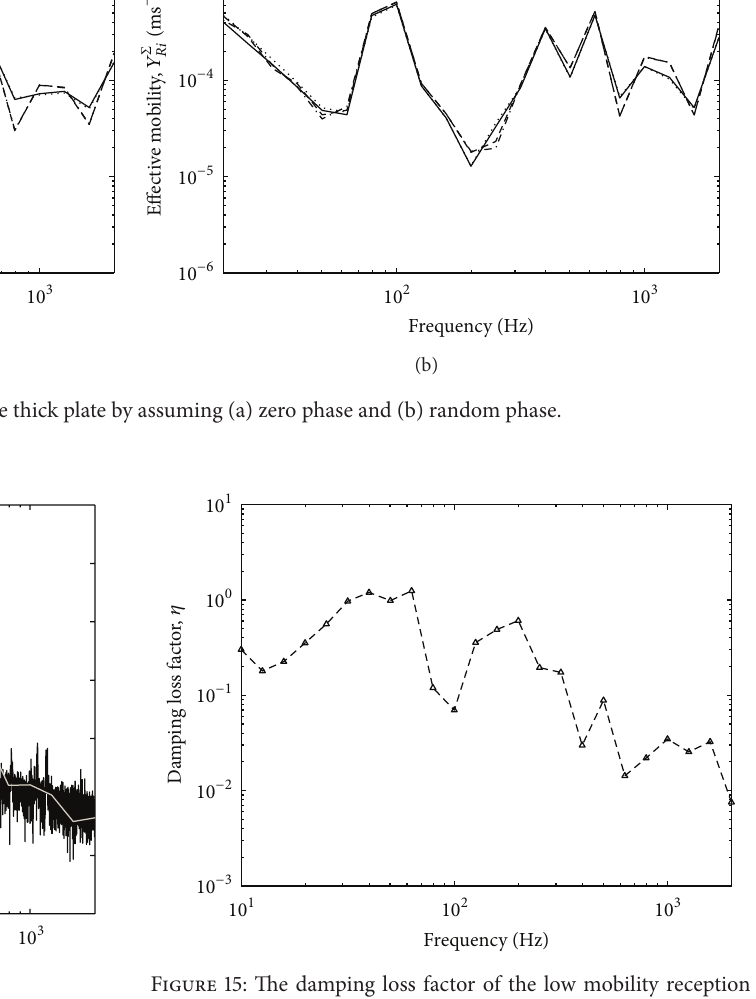
Figure 14: The measured spatially average mean-squared velocity of the low mobility reception plate (grey line: one-third octave band).